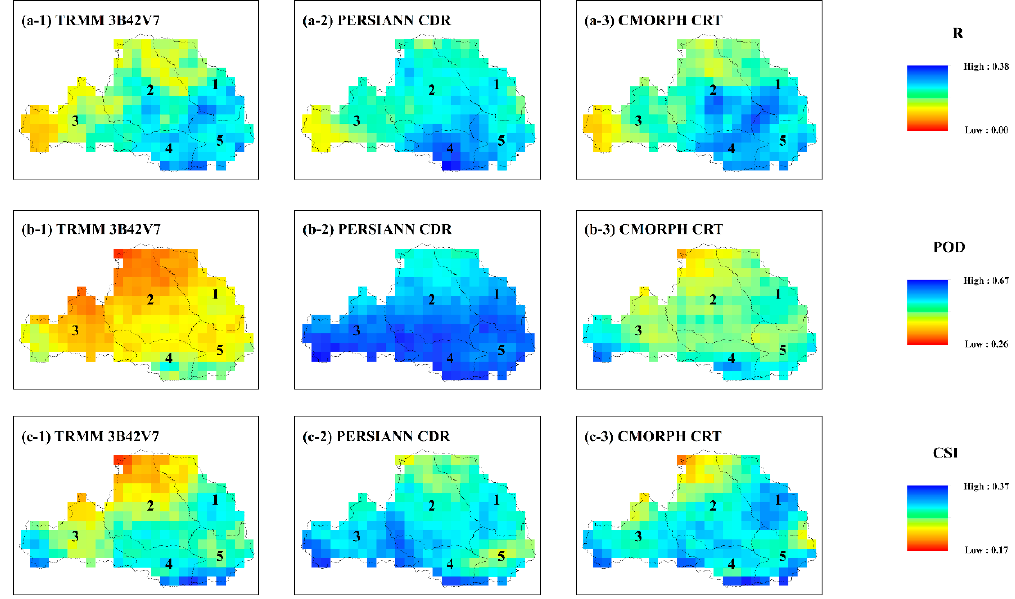
Figure 3. The spatial distribution of the three evaluation metrics ( a-1 , a-2, a-3 ) R, ( b-1 , b-2 , b-3 ) POD and ( c-1 , c-2 , c-3 ) CSI for the three post real-time products at the daily and grid scale.